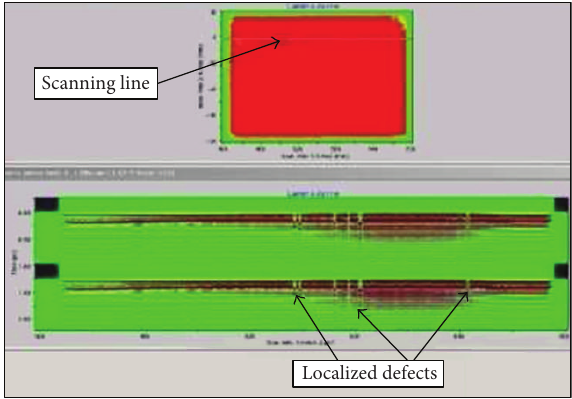
F 3: Linear scanning of metal-polymer composite showing delamination points at the interface.